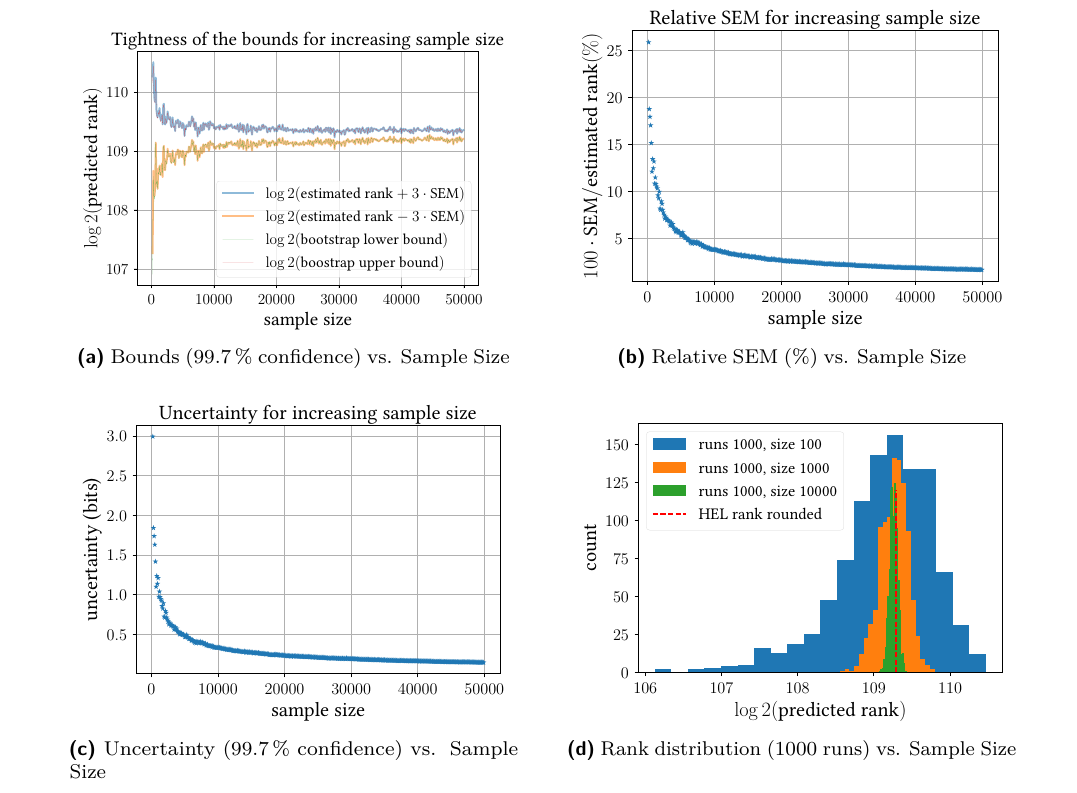
Figure 2: AES-128. MCRank quickly converges to accurate rank estimates for increasing sample size. Confidence interval (a), relative SEM (b), and uncertainty (c) (i.e., logarithm of the ratio between upper and lower bound) rapidly become smaller. The confidence interval is computed from the SEM: under the assumption that the error is normally distributed (d), the rank falls in the ± 3 SEM interval with 99.7 % confidence. Using the bootstrap method with α =0 . 003 provides the same bounds